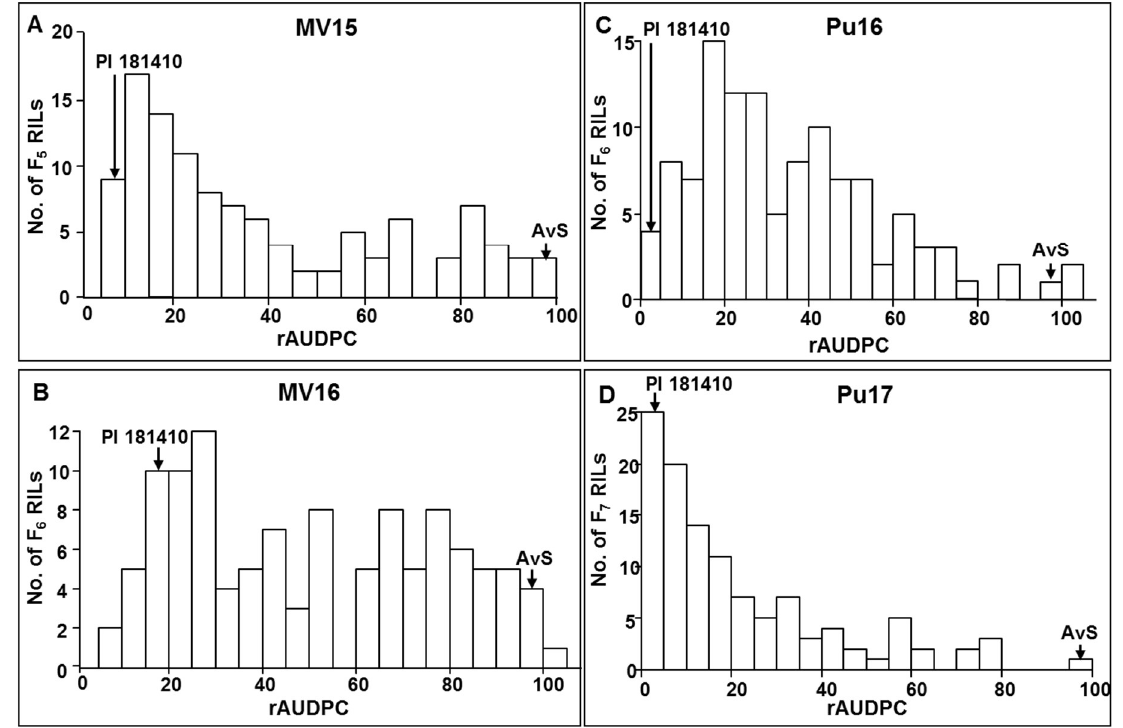
Figure 1. The distribution of infection types (ITs) among F 7 recombinant inbred lines (RILs) derived from the cross AvS × PI 181410 tested in greenhouse using races ( A ) PSTv-4 and ( B ) PSTv-14 of Puccinia striiformis f. sp. tritici .